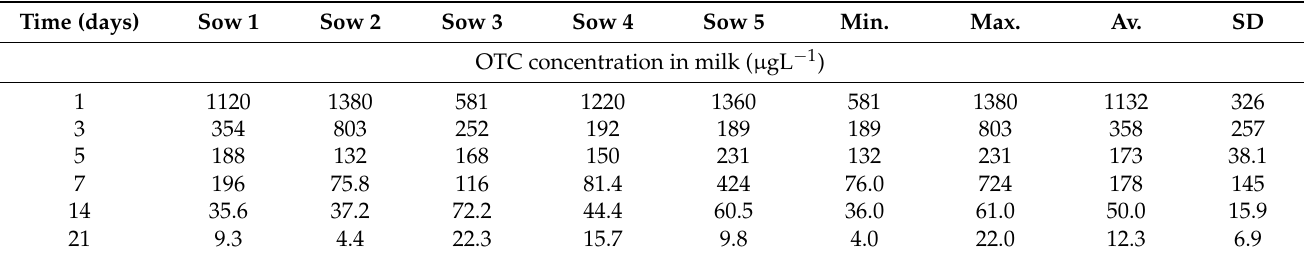
Table 2. Concentrations of oxytetracycline (OTC) in sow milk after a single intramuscular administra- tion of a long-acting form of the drug at a single dose of 30 mg per kg of body weight.